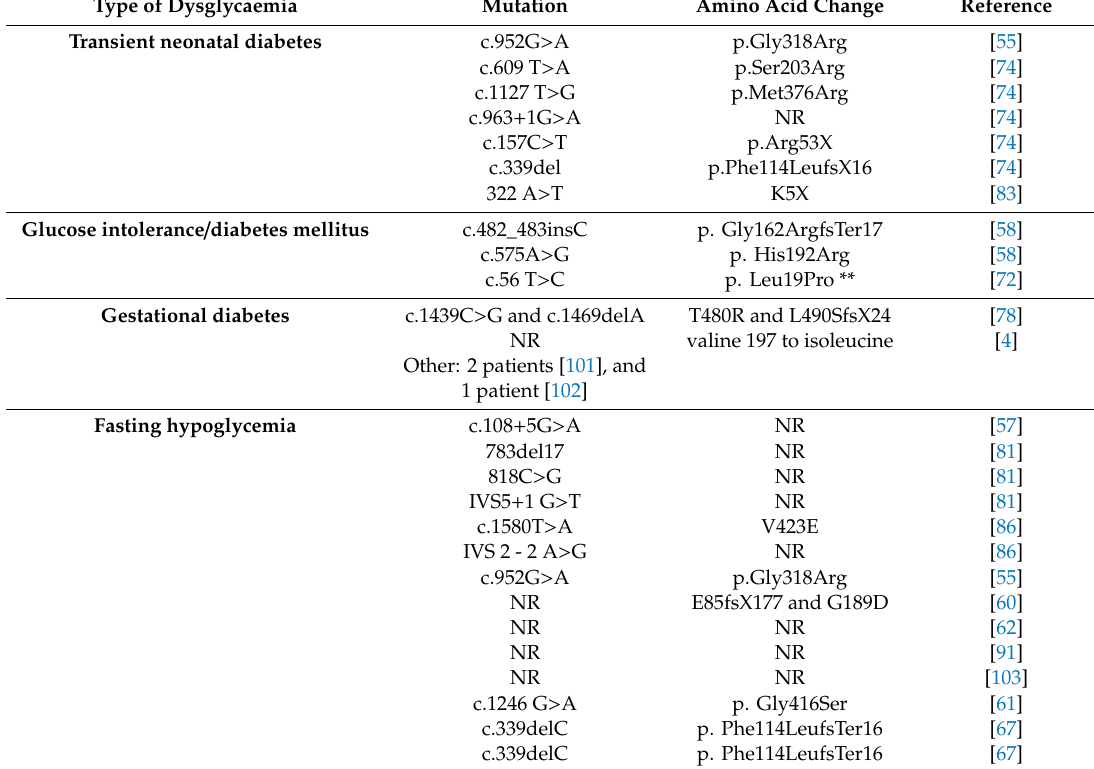
Figure 3. Human glucose transporter 2 (GLUT2) structural topology including location of variants and conserved amino acids. GLUT2 is a glucose transporter containing 12 transmembrane domains (524 amino acids) connected with extracellular and intracellular loops, facilitating the movement of glucose across the cell membranes. It has high capacity but low a ffi nity (high km) for glucose, and functions as a glucose sensor. GLUT2 mediates bidirectional glucose transport, and is mostly expressed in pancreatic β -cells, liver, small intestine, brain and renal tubular cells. Table 3. All of the SLC2A2 gene mutations where dysglycaemia associated with FBS has been reported. Type of Dysglycaemia Mutation Amino Acid Change